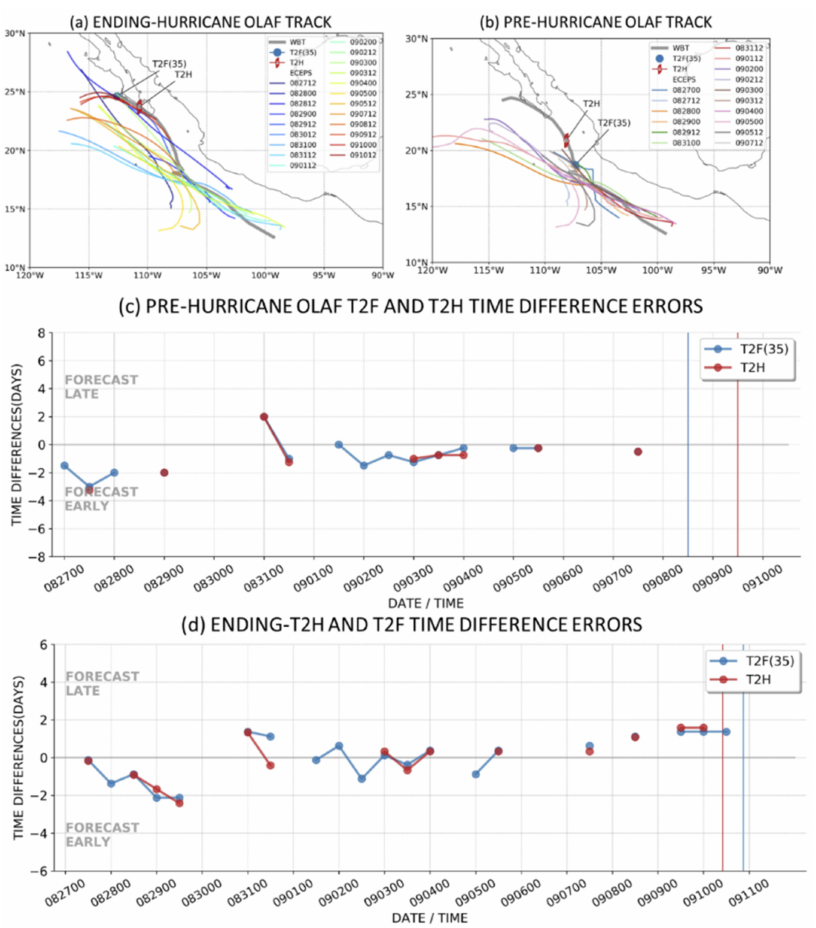
Figure 13. Summary of the ECEPS pre-formation and ending-storm predictions as in Figure 3 except here for the Hurricane Olaf